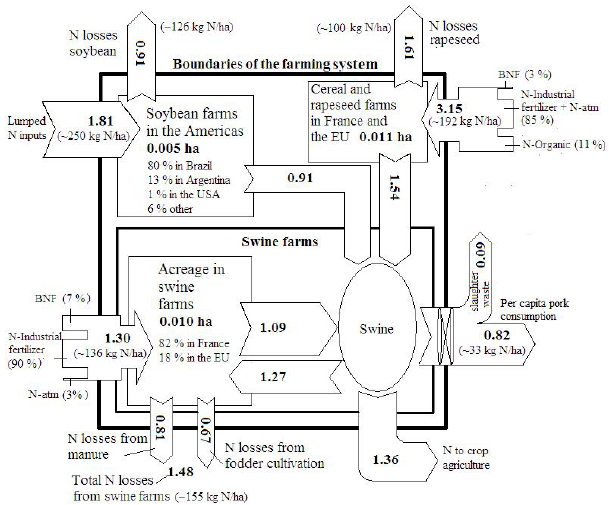
Fig. 7. Nitrogen and land requirements associated with the pro- duction of pork. Arrows (bold type) refer to per capita N flows (kgNcapyr − 1 ) and rectangles to per capita land requirements (hacap − 1 yr − 1 ) per country of feed production. N input and out- put per hectare are given in brackets (kgNha − 1